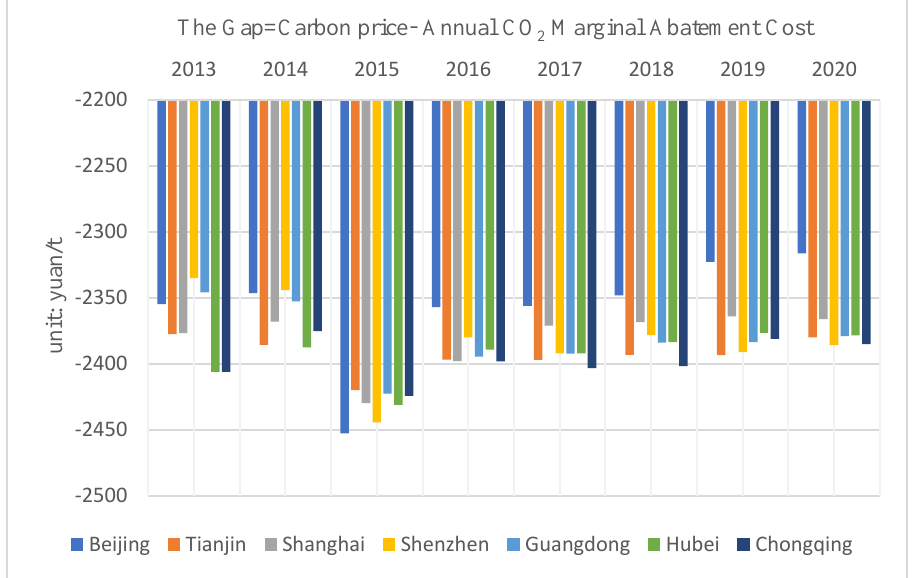
Figure 4. The gap between the average annual carbon price and the average annual MAC of CO 2 .